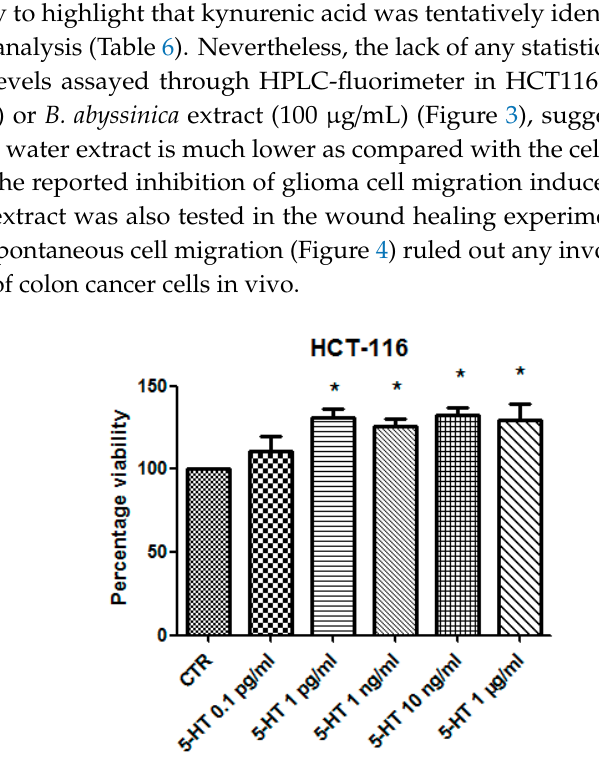
Figure 2. Effects of B. abyssinica water extract 100 μ g/mL basal and serotonin (5-HT)-induced on colon cancer HCT116 cell viability (MTT test). Data are means ± SD and analyzed through analysis of variance (ANOVA), followed by post hoc Newman–Keuls test. ANOVA, p < 0.0001; post hoc , *** p < 0.001 vs. 5- HT (serotonin) group. The B. abyss. 100 μ g/mL group reported in the picture was compared with the sole CTR group ( p > 0.05).